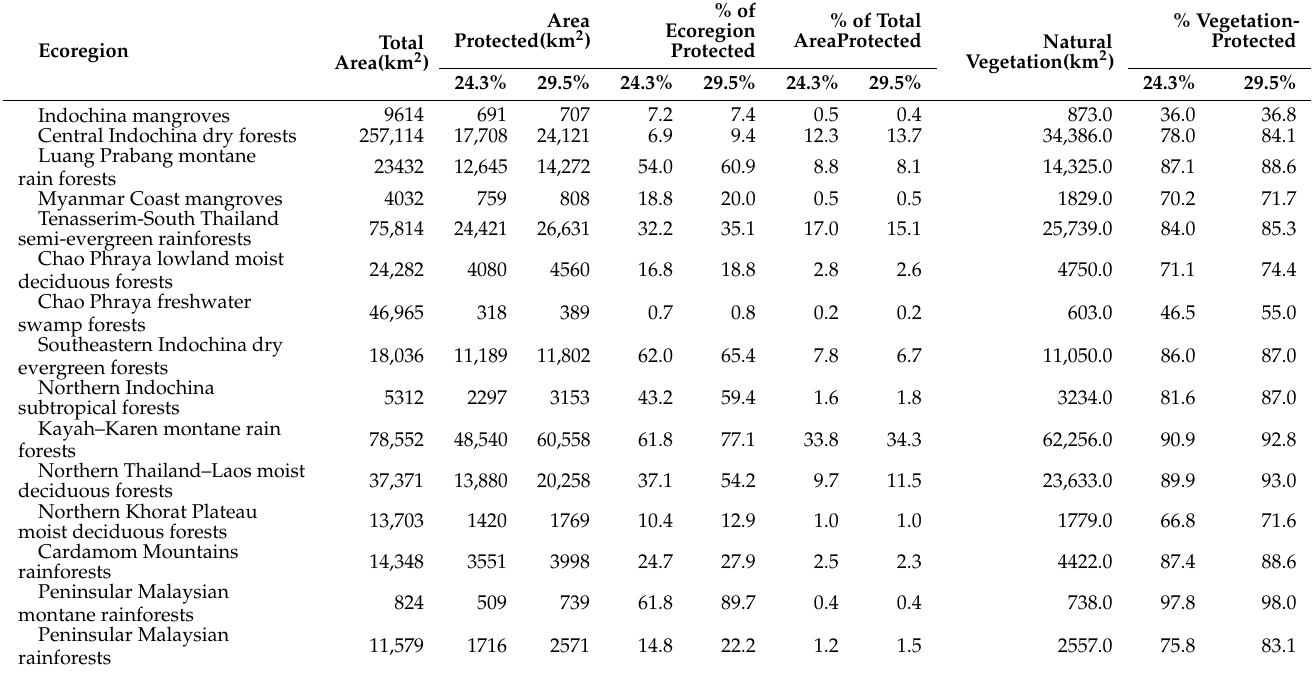
Table 4. Representation of the 15 WWF ecoregions present in Thailand in protected areas, currently (24.3%) and after expansion (29.5%).